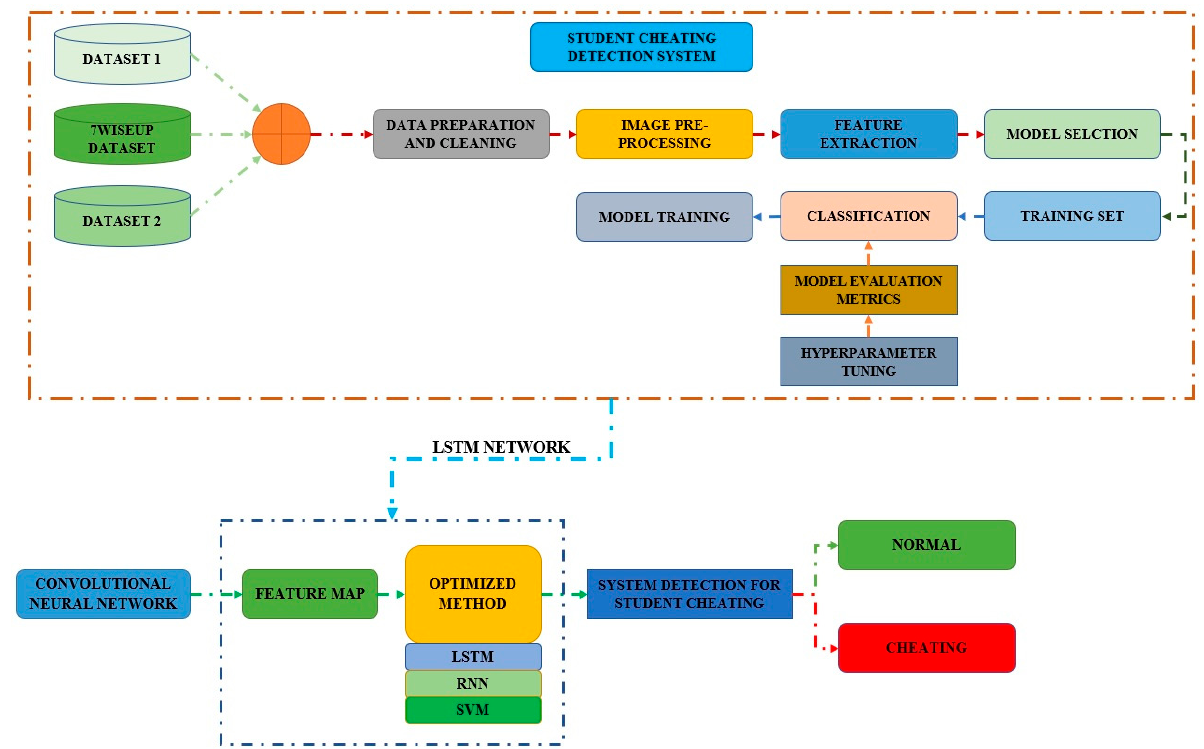
Figure 1. Framework of the proposed model diagram related to student cheating detection system.